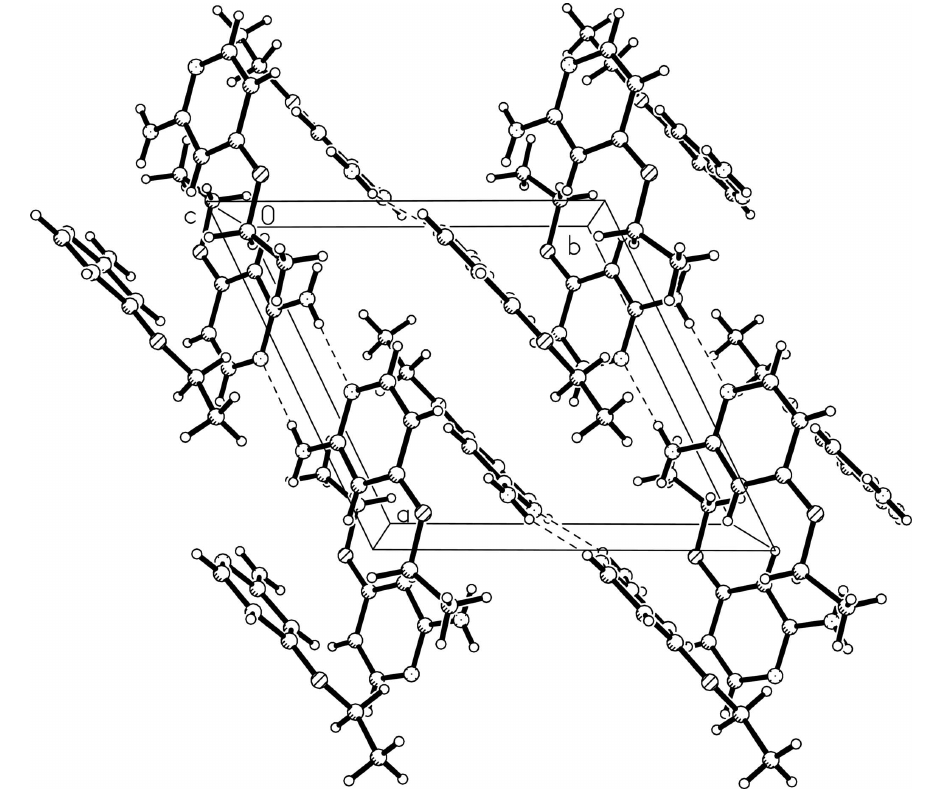
Packing diagram of structure of (I), view along the c axis. Hydrogen bonds are shown as dashed